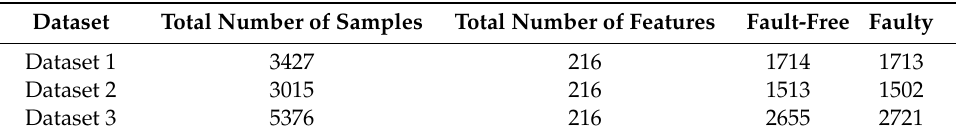
Table 2. Dataset description.